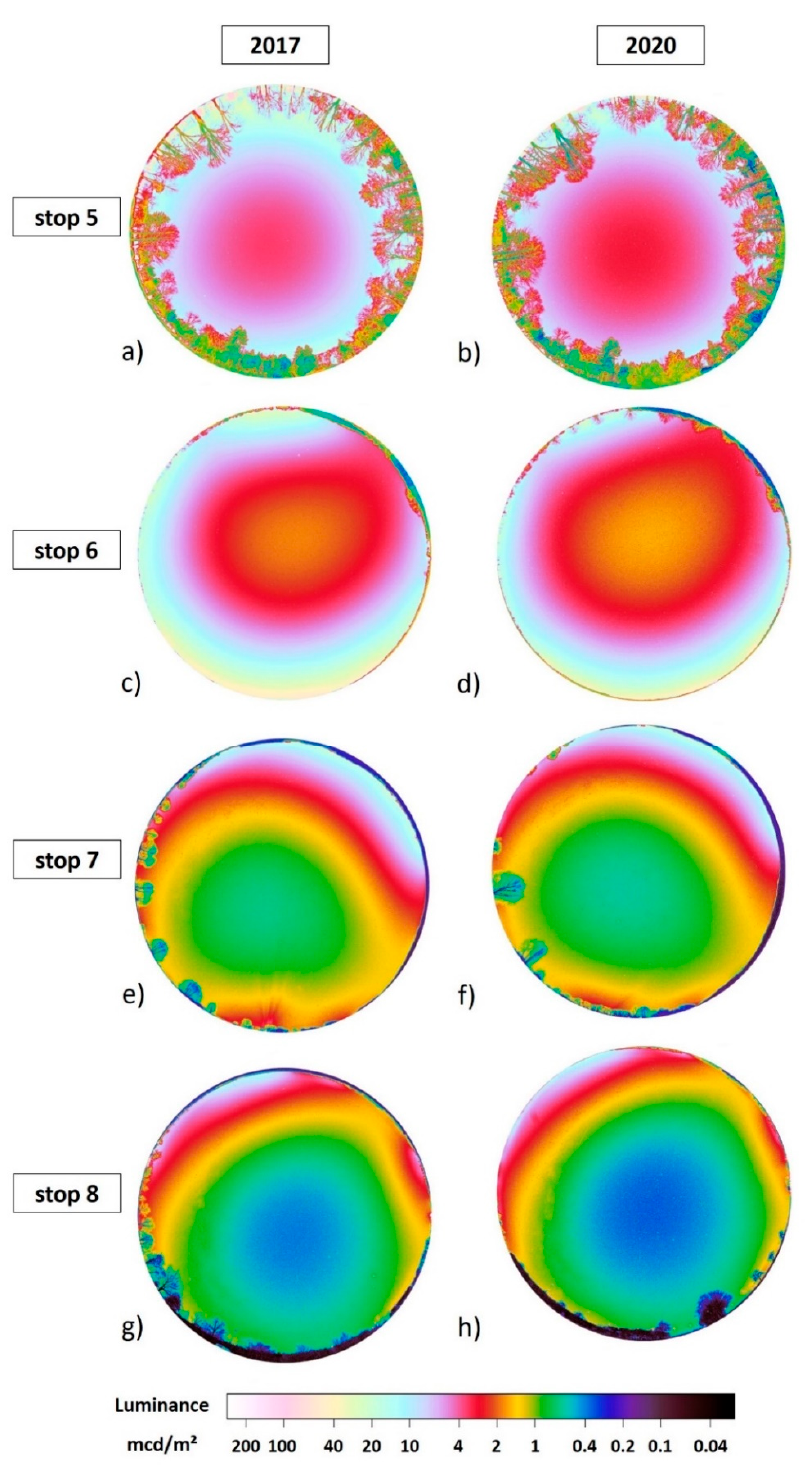
Figure A2. Luminance maps for stops 5–8. ( a , c , e , g ) 2017 data, ( b , d , f , h ) 2020 data.